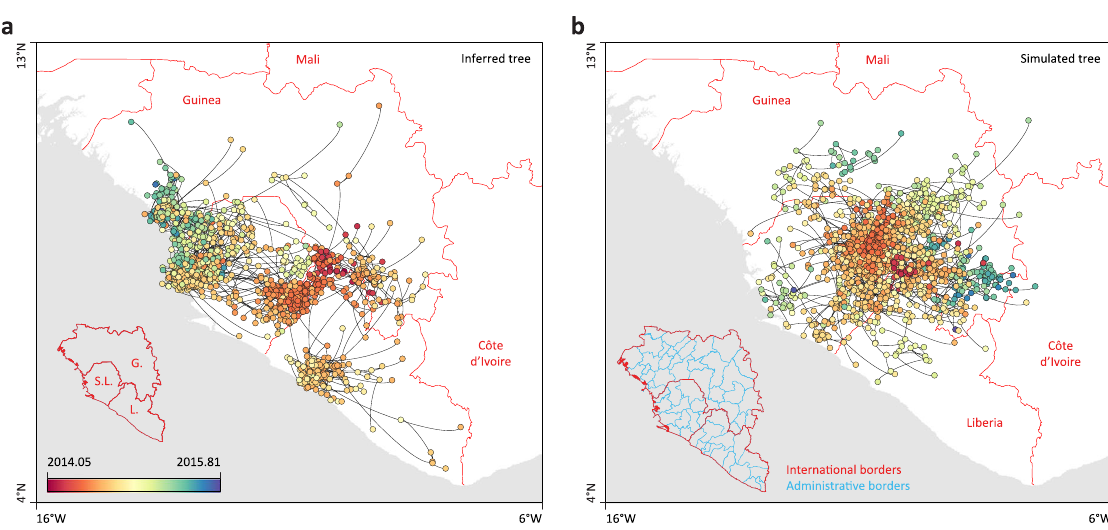
Fig. 2 Example of a continuous phylogeographic estimate and corresponding simulation. Example of a phylogeographic estimate in continuous space ( a ) and the corresponding posterior predictive simulation unaware of international borders ( b ). In both cases, phylogenetic branches are represented by black curves connecting phylogenetic nodes displayed as dots coloured according to their time of occurrence. In a , these nodes are positioned according to the mean latitude and longitude estimates obtained by phylogeographic inference, while in b they are positioned according to simulations based on the estimated parameters of the phylogeographic process. Map background was made in R and based on international borders obtained from the Global Administrative Areas database (GADM,